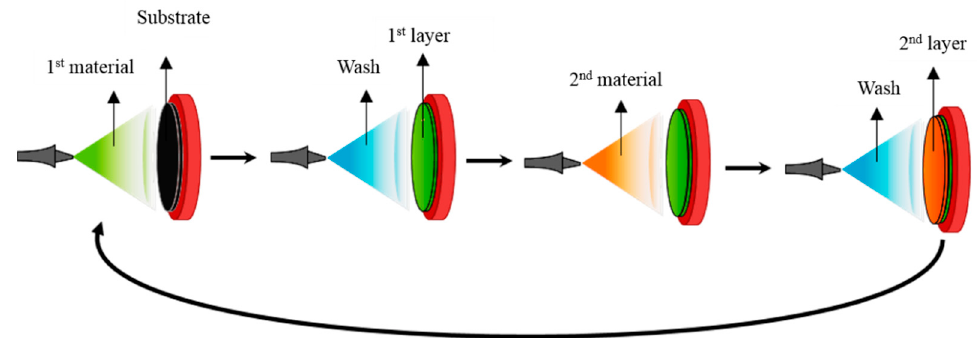
Figure 11. Schematic illustration of the spray assembly.